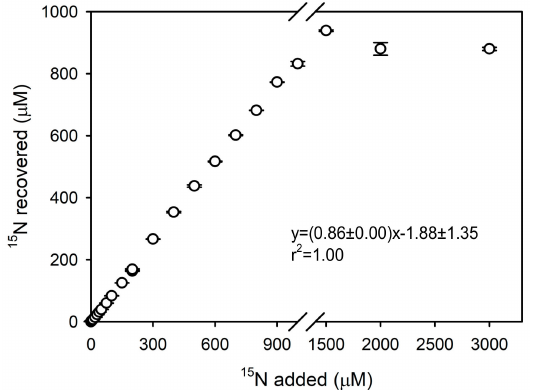
Figure 4. Recovered versus added 15 N-NO 3 − in a concentration series experiment. In addition, 24 standard solutions with increasing concentrations of 15 N-NO 3 − (from 0 to 3000 µ M 15 N-NO 3 − ) were added to the sediment slurries and the produced labelled dinitrogen was quantified. The linear regression was calculated over the 0–800 µ M 15 N-NO 3 − range. Each slurry was run in triplicate; averages and standard errors are reported.